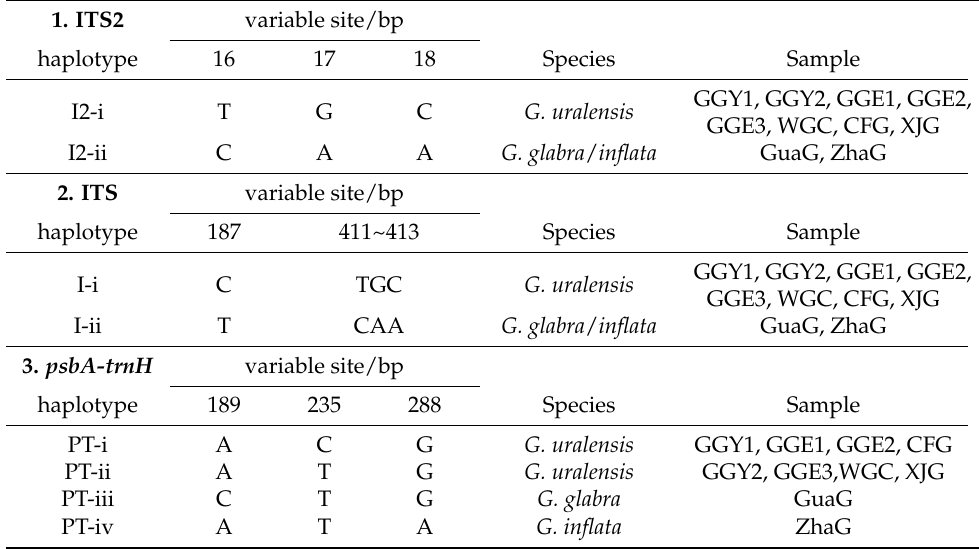
Table 1. Variation loci of licorice in three molecular markers and identification results of seed samples. 1.